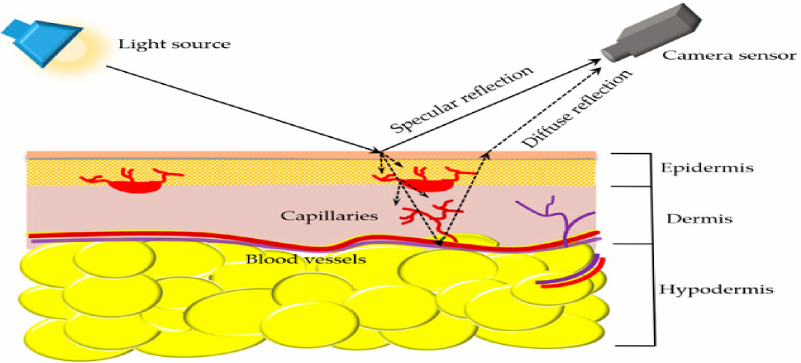
Figure 6. Skin reflection model of imaging photoplethysmography (iPPG) [adapted from